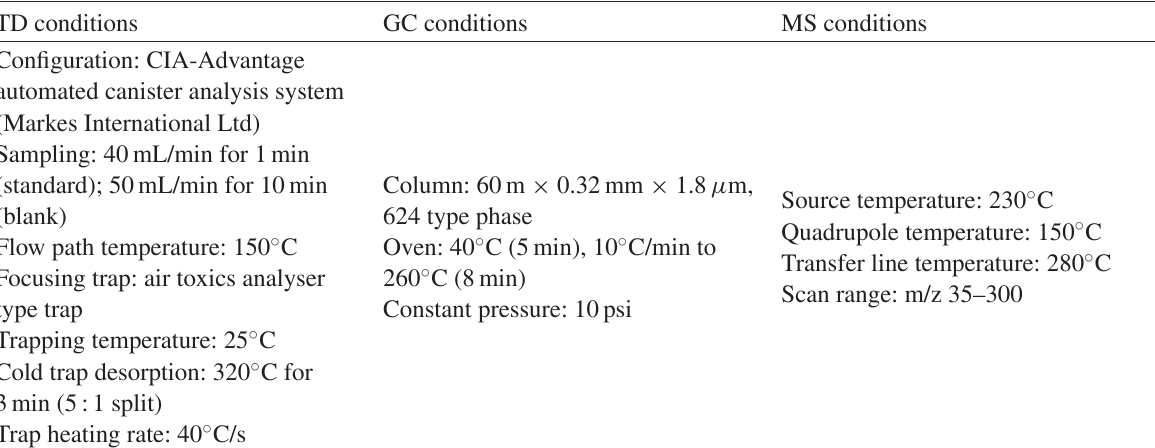
TABLE 2: Analytical